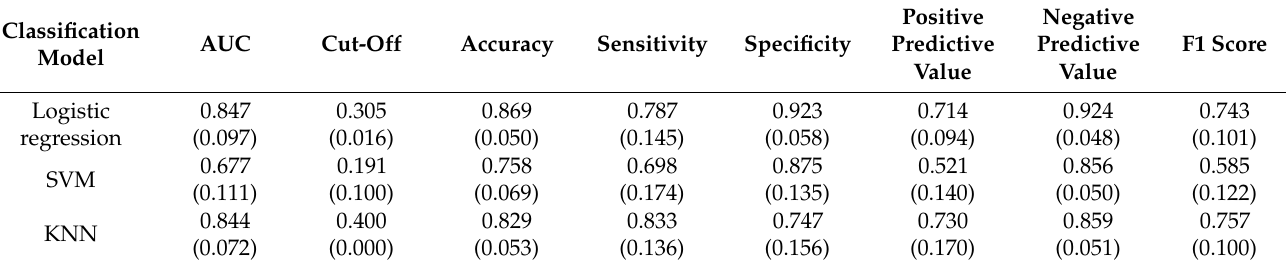
Table 4. Multimodel classification—validation cohort *.